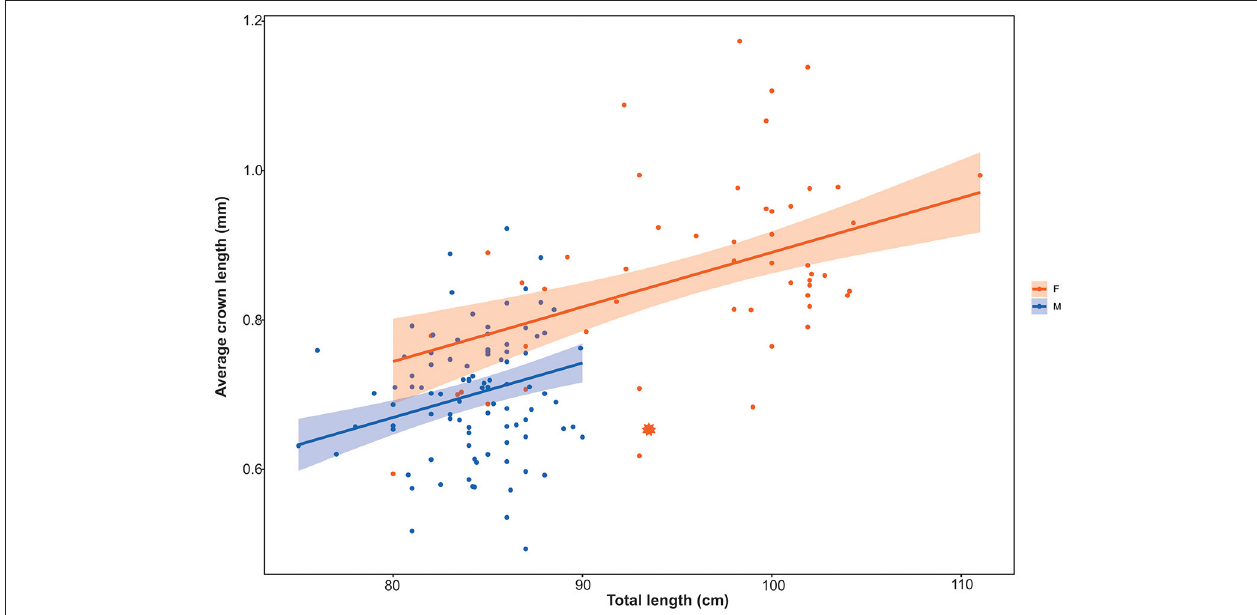
FIGURE 6 | Crown denticle size plotted against specimen total length for D. calcea , showing the regression lines and respective 95% confidence intervals calculated by the model and data colour coded by sex. * = MAD115, specimen belonging to the D. calcea2